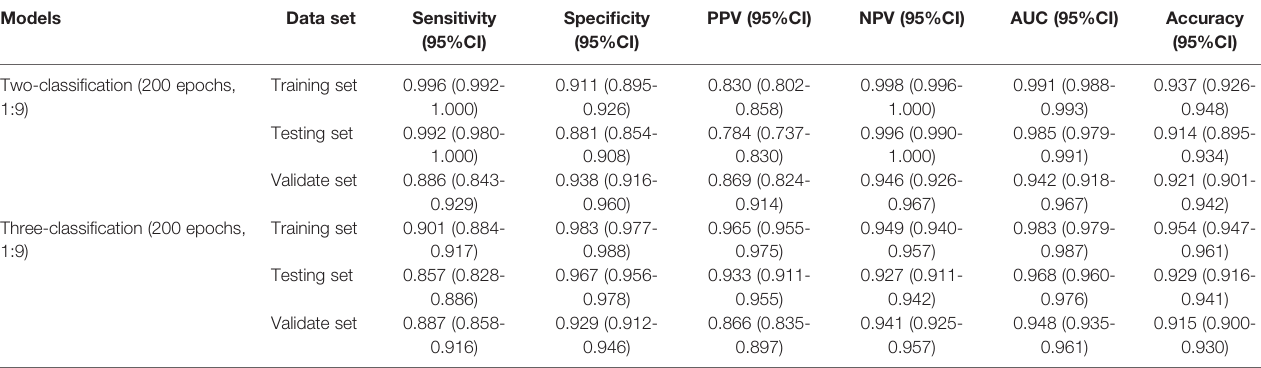
TABLE 5 | The performances of the fi nal two-classi fi cation and the three-classi fi cation models.